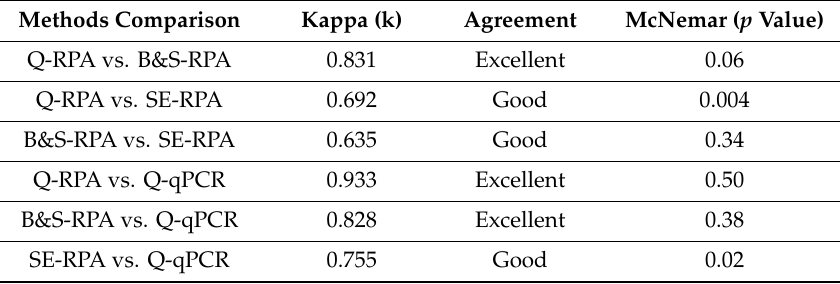
Table 3. Agreement between di ff erent DNA extraction methods coupled with the RPA assay and spin-column-based (Qiagen) DNA extraction method together with qPCR